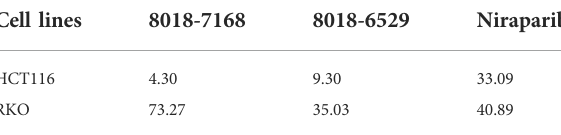
TABLE 3 The IC50 values of anti-tumor activities of compound 8018- 7168, 8018-6529 and Niraparib against HCT-116 and RKO cell lines. The unit of concentration is μ